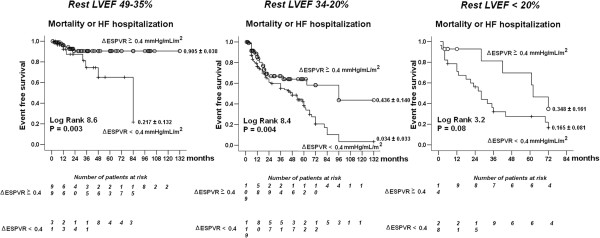
Survival in patients with negative stress echo and different rest LV dysfunction. Kaplan-Meier survival curves (considering combined death or HF hospitalization as an endpoint) in medically treated patients stratified according to the presence of stress end-systolic pressure-volume relation-based contractile reserve (ΔESPVR ≥ 0.4 mmHg/mL/m2 vs rest as cut-off value) in patient with moderate (left panel), severe (middle panel), or extreme (right panel) rest LV dysfunction.